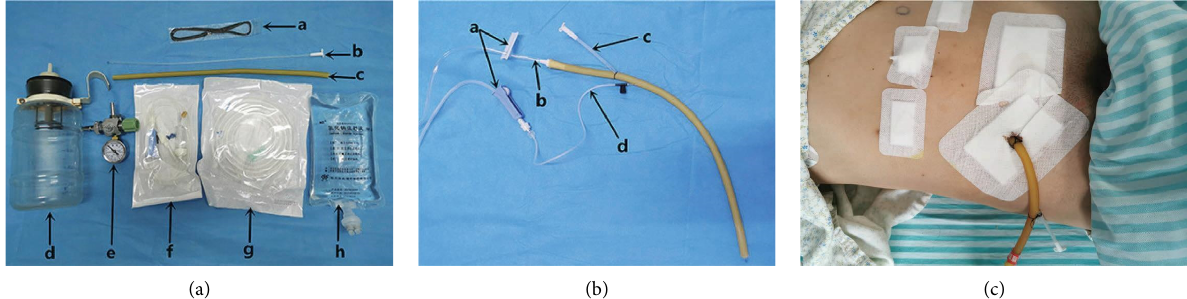
Figure 1: Self-made double cannula. (a) Self-made double cannula subassembly. Notes. (A) #7 silk thread, (B) #12 ventricular drainage tube, (C) rubber drainage tube, (D) negative pressure drainage bottle, (E) pressure gauge, (F) infusion set, (G) suction tube, (H) normal saline. (b) Self-made double cannula sample. Notes. (A) controllable switch, (B) connected to drainage bag, (C) connected to negative pressure suction tube, (D) fushing tube. (c) Practical application of self-made double